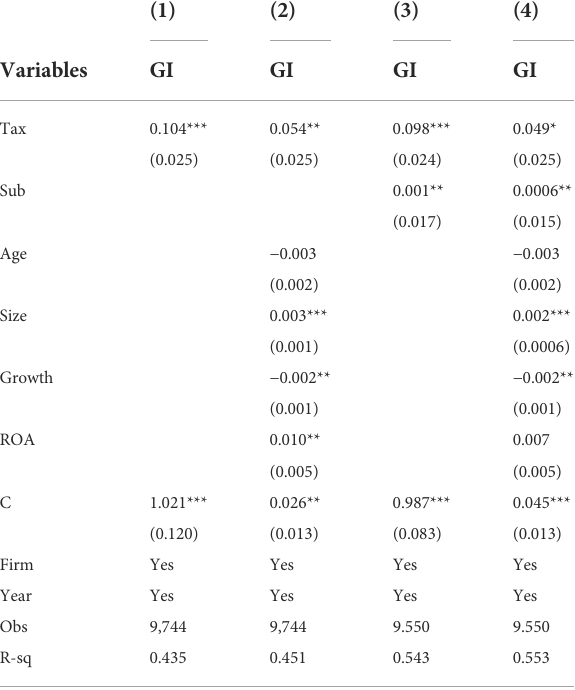
Table 4 tests the mediating effect of fi nancing constraints and the moderating effect of subsidies. In column (1), the coef fi cient of GI on green innovation is 0.054 at 5% signi fi cant level. In column (2), the coef fi cient of DT on KZ is 0.-0.463 at 1% signi fi cant level. In column (3), the coef fi cient of KZ on GI is